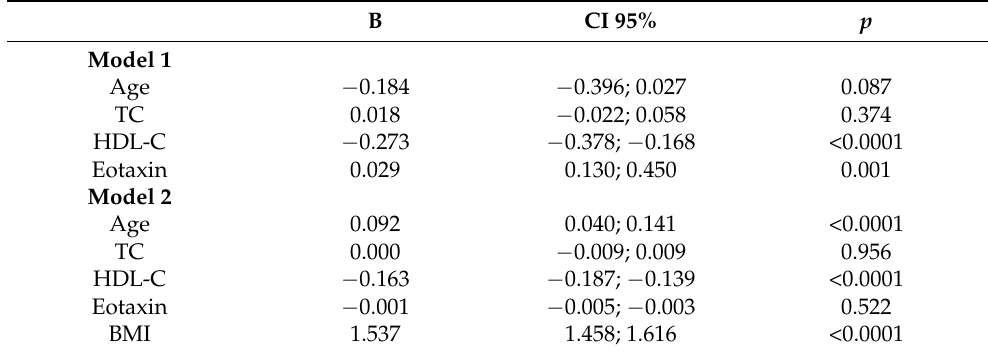
Table 5. Linear regression analyses exploring the association of Eotaxin with METS-IR, controlling for multiple confounding factors in women ( n = 82). B